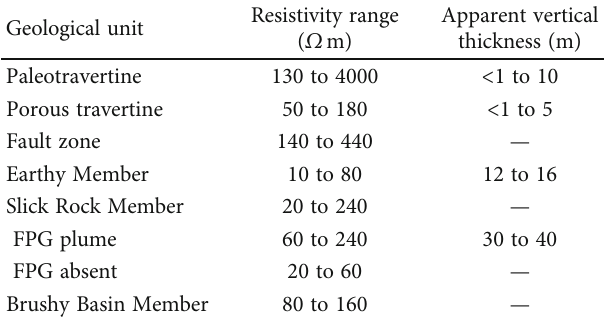
Table 1: Summary of resistivity ranges and tomogram-estimated vertical thicknesses for interpreted tomogram units. FPG: free- phase gas. Resistivity ranges are the 5 th and 95 th percentile resistivities for each